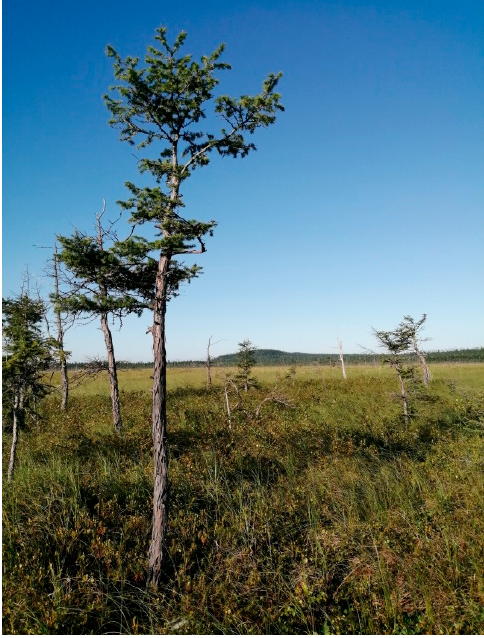
Figure 4. String with sparse Larix trees, A3